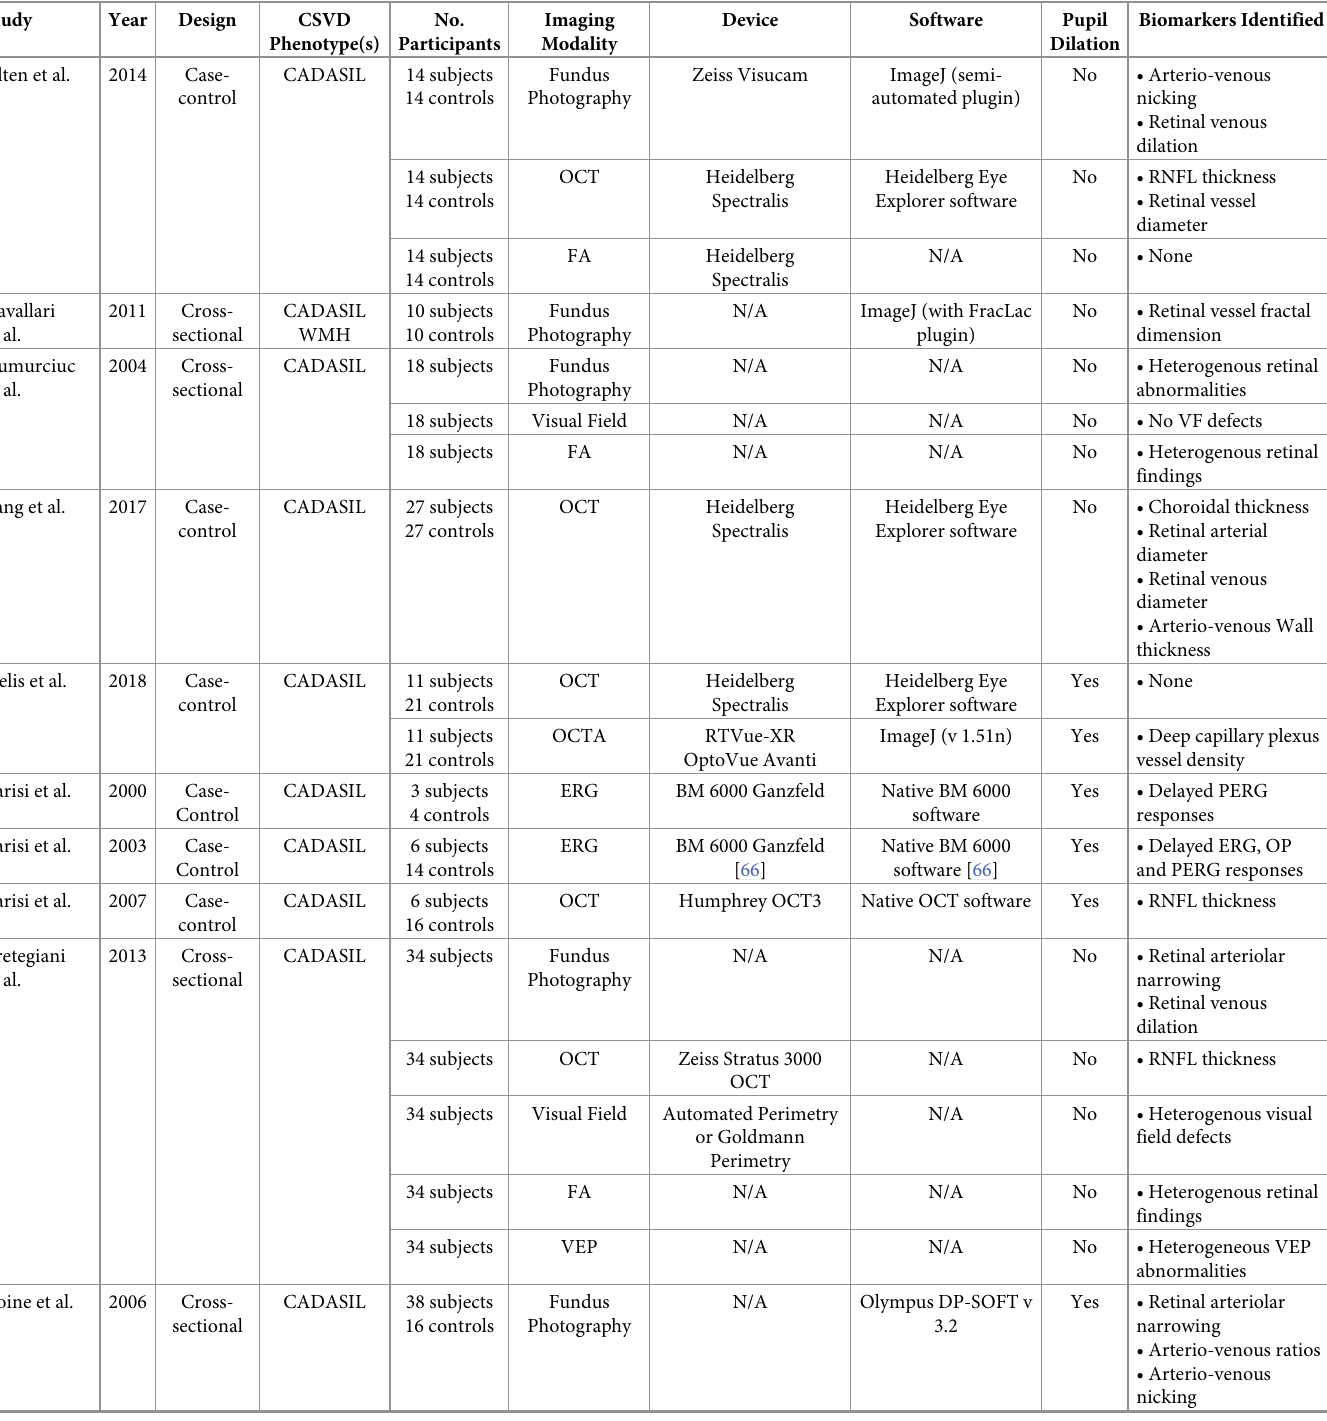
Table 6. Summary of design, patient characteristics, methodology and results for studies of